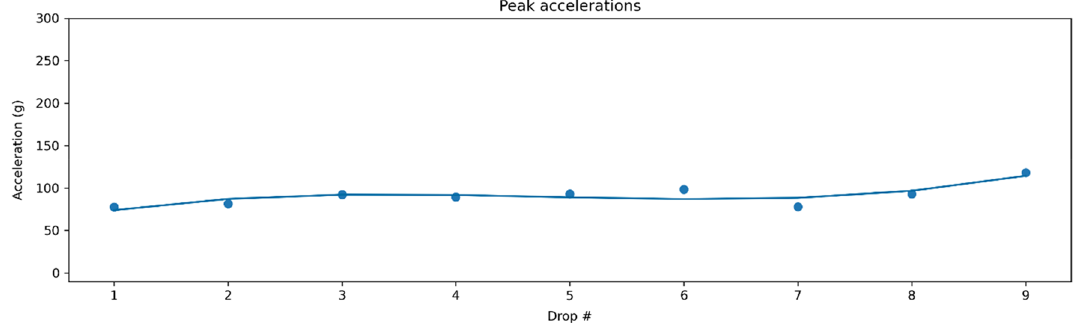
Fig. 7 Peak accelerations for each drop of P1 (400 g / 200 × 100 × 31 mm / 3–3-3 wrapping pattern) Fig. 8 Peak accelerations for three different drop sequences with P1 (400 g / 200 × 100 × 31 mm / 3–3-3 wrapping